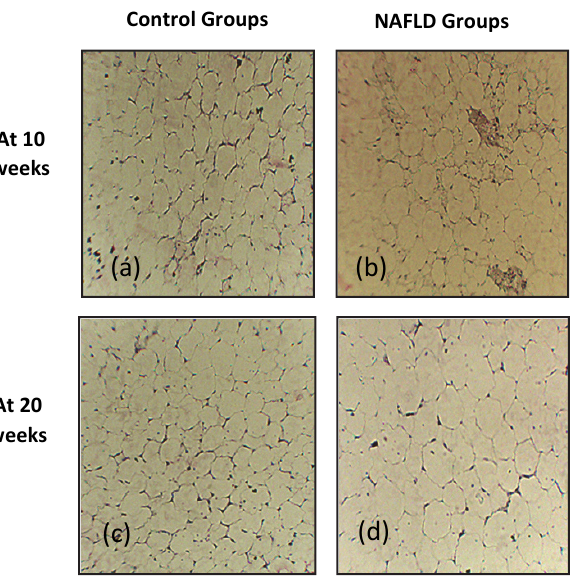
Fig. 3. Abdominal adipose tissue of rats in the control groups consuming water without sucrose (a, c) and hypertrophic adipose tissue in rats consuming sucrose for 10 weeks in NAFLD-10 group (b) and 20 weeks in NAFLD-20 group (d).